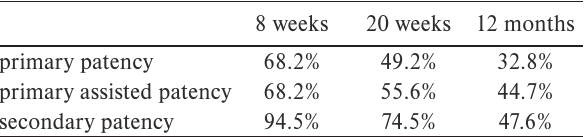
Fig. 3. Primary AVG patency in peroperative angioplasty and stent graft implantation into the VAG. Table 1. Results of AVG thrombectomy with peroperative angioplasty and stent graft implantation into the